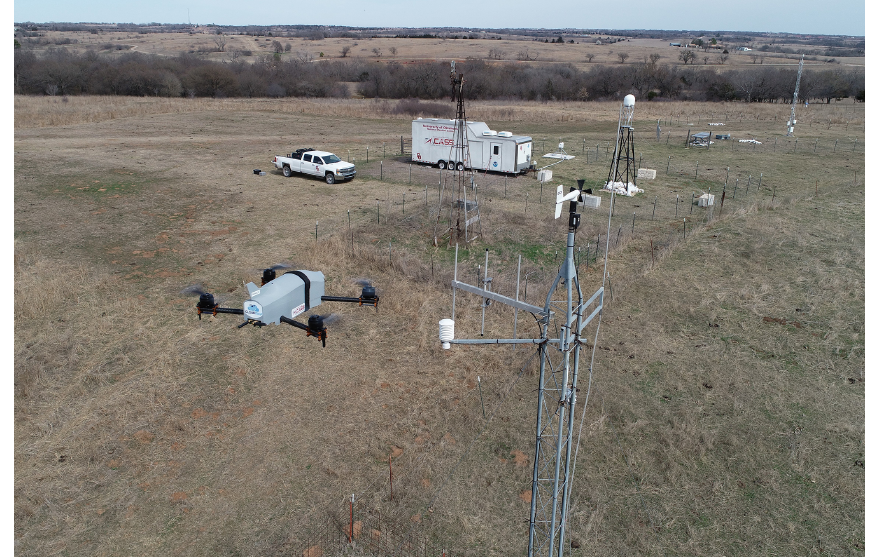
Figure 8. Picture of the CopterSonde hovering and tracking the wind next to the Oklahoma Mesonet tower at KAEFS. The aerial photo was taken by a DJI Phantom 4 Pro drone from